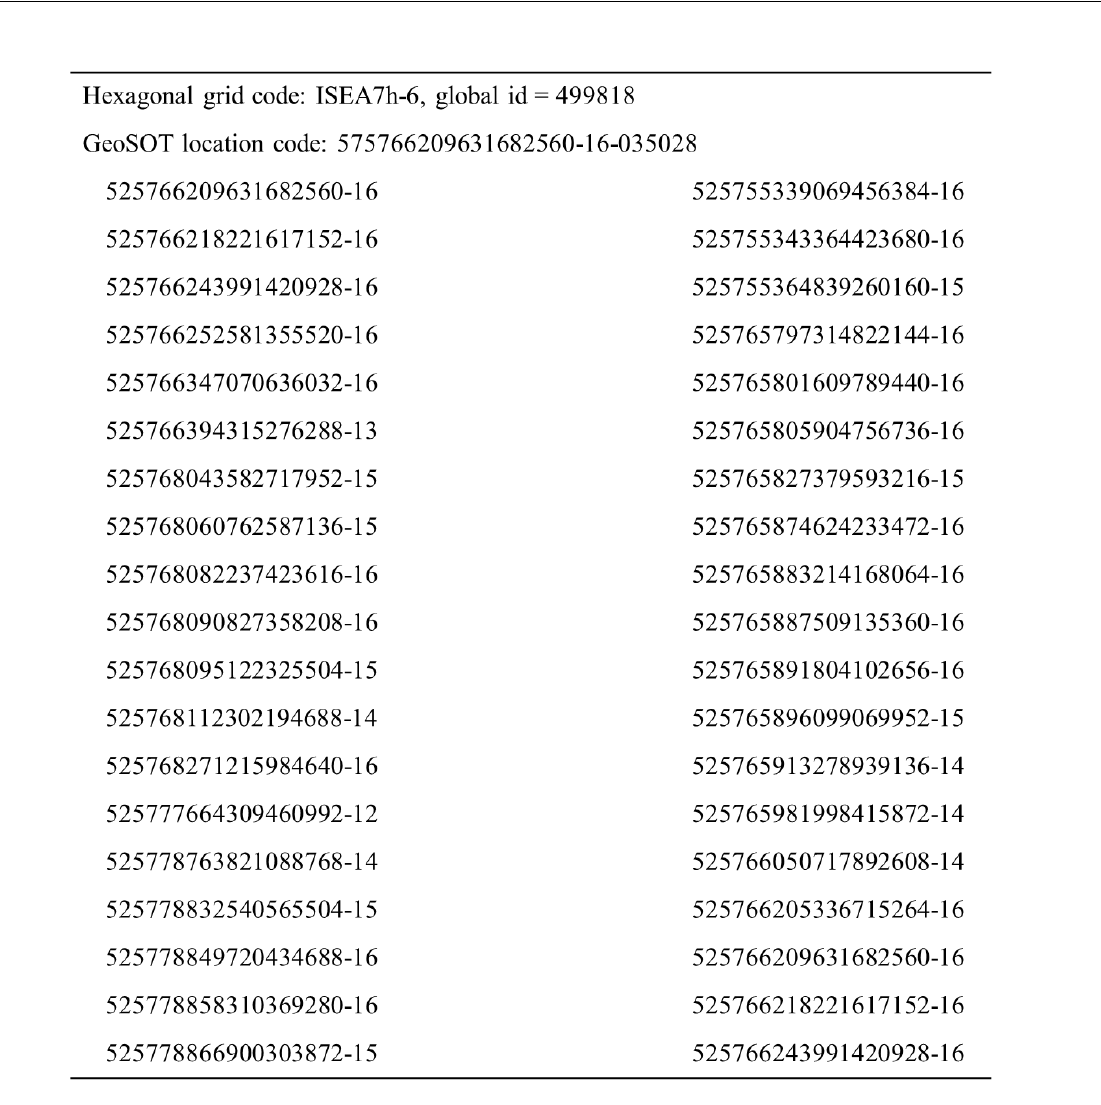
Figure 12. The heat map of POI distribution expressed in hexagonal grid using the GEA model.